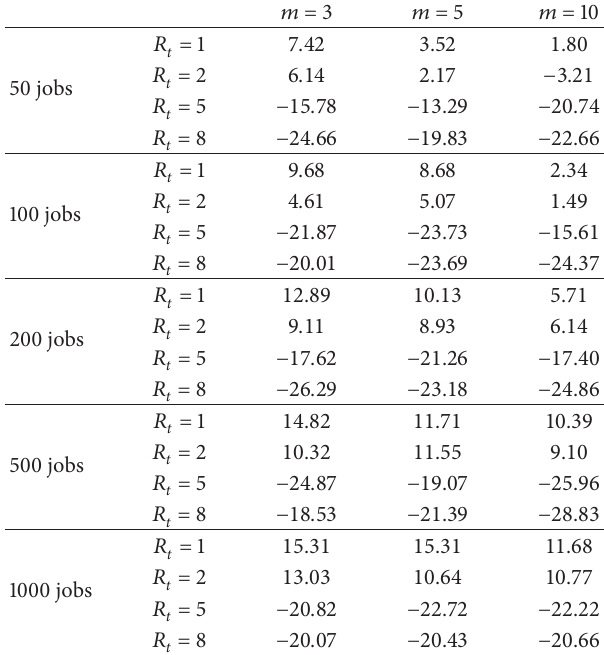
Table 1: Performance comparison of MGS and DSJF (uniform